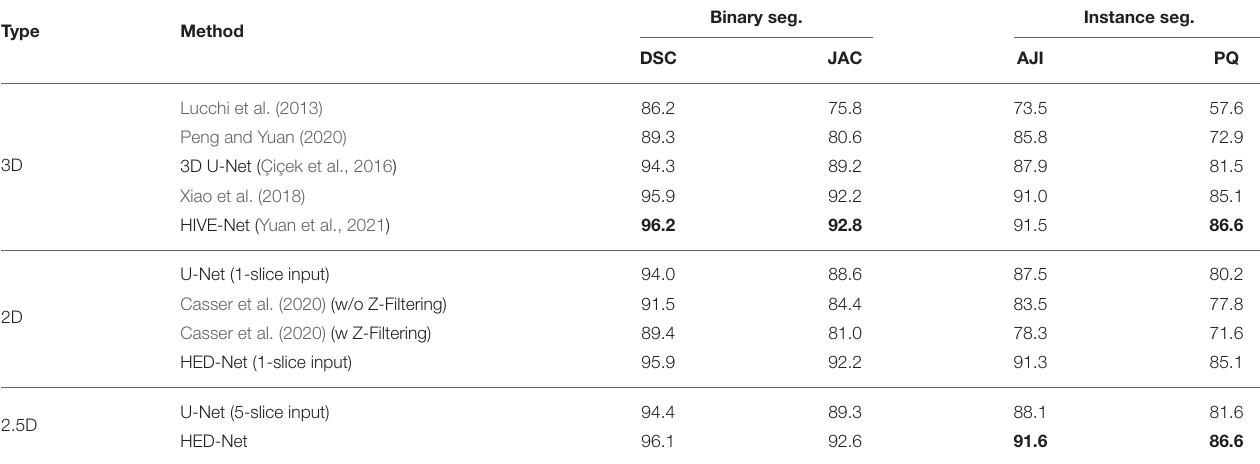
TABLE 2 | Comparison of the proposed method with other 2D/3D top-performing methods for mitochondria segmentation on Kasthuri++ dataset.